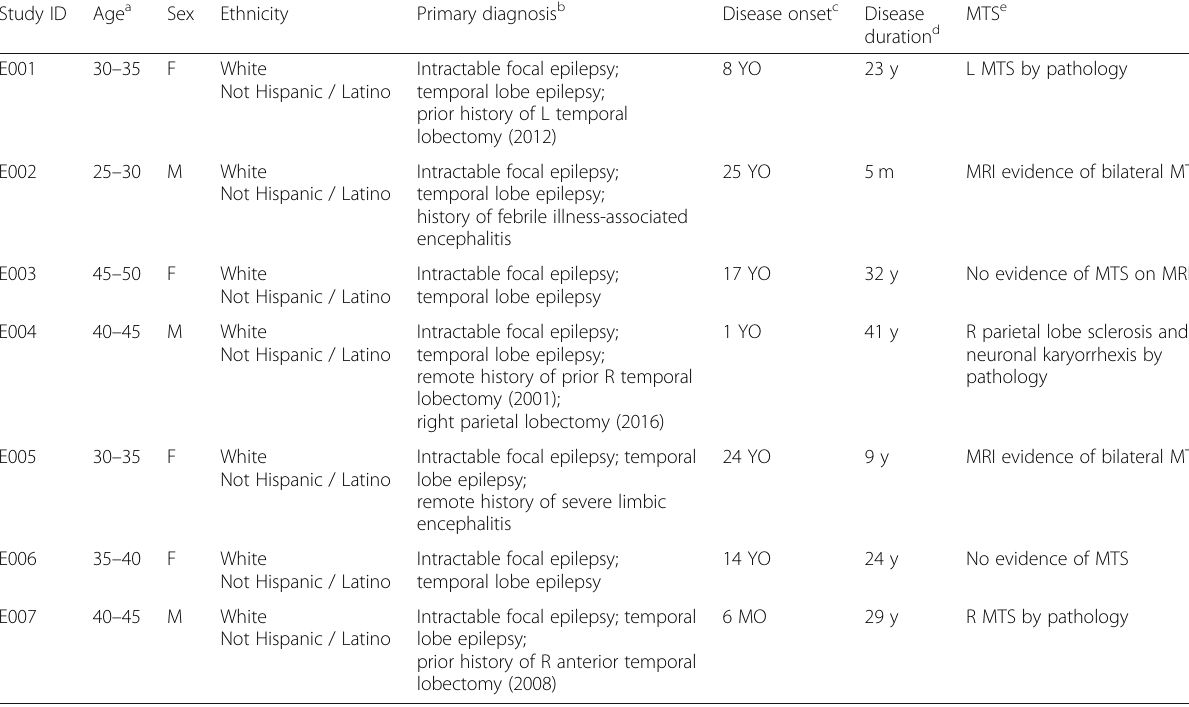
Table 1 Demographic information for subjects with intractable focal